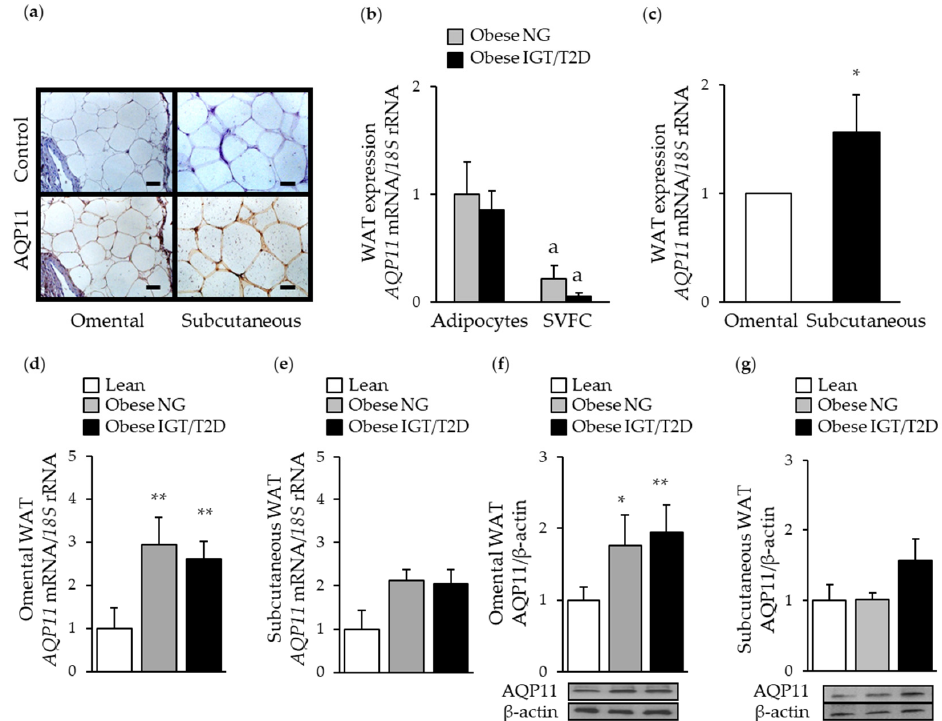
Figure 1. Impact of obesity and obesity-associated T2D on AQP11 expression in paired omental and subcutaneous adipose tissue samples. ( a ) Immunohistochemical detection of AQP11 in omental (left panels) and subcutaneous (right panels) fat depots obtained from patients with obesity (magnification, × 200; scale bar = 50 µ m). Comparison of mRNA levels of AQP11 in freshly isolated adipocytes and SVFC from omental WAT from patients with obesity classified according to their degree of insulin resistance ( b ) as well as in human omental and subcutaneous white adipose tissue (WAT) ( c ). Bar graphs show the expression of AQP11 mRNA and protein in omental ( d and f ) and subcutaneous ( e and g ) WAT obtained from lean individuals, obese patients with normoglycemia (NG), impaired glucose tolerance (IGT), or type 2 diabetes (T2D). Representative blots are shown at the bottom of the histograms. * p < 0.05, ** p < 0.01 vs. mRNA expression in omental WAT or in lean subjects. a p < 0.05 vs. mRNA expression in the adipocyte